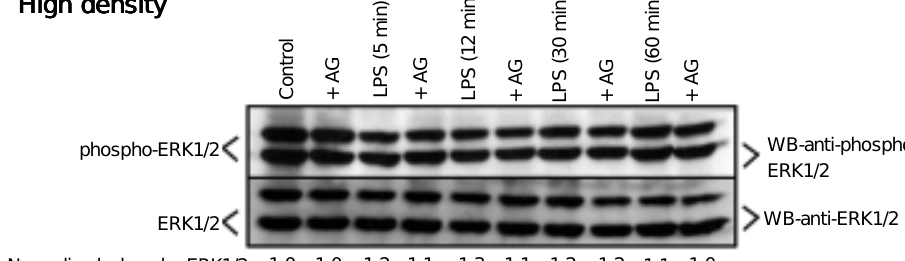
Figure 4. Time-dependent lipo- polysaccharide (LPS) stimulation of rabbit vascular smooth muscle cells (RVSMC) for ERK1/ ERK2 activities. Low-density, non-confluent RVSMC (A) and multilayered cultures (B) were stimulated with LPS for the indi- cated periods of time and ERK1/ ERK2 activities were estimated using anti-phospho-ERK1/2 and anti-ERK1/2 antibodies as de- scribed in Material and Methods. Representative Western blots (WB) of both situations are shown. AG =